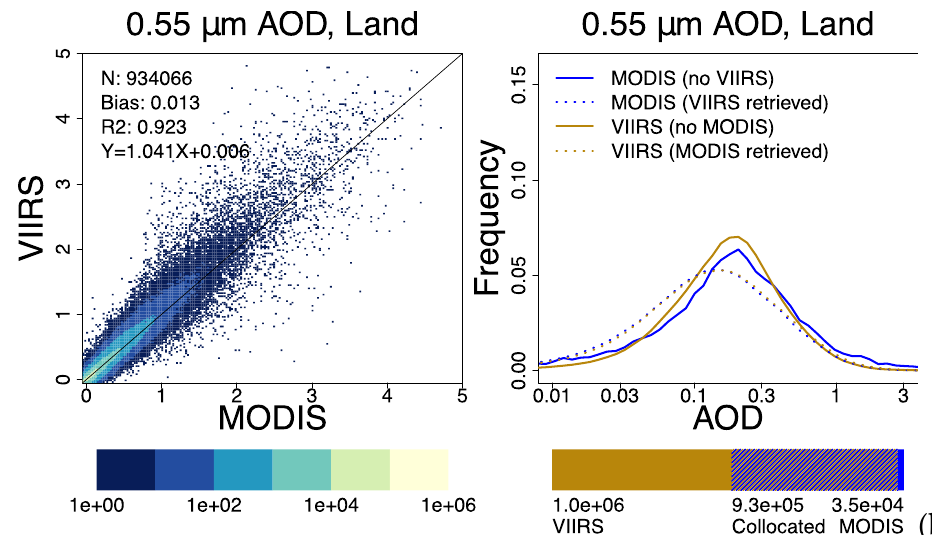
Figure 5. Comparison of all 0.55 µ m AOD daily average one-degree grid cells throughout 2015. Left, scatterplots of collocated MODIS Aqua and VIIRS SNPP cells; right, histogram frequencies where MODIS and VIIRS were collocated (dotted lines) and where only one sensor retrieved AOD (solid lines). The horizontal bar on the right indicates the number of collocated and non-collocated grid cells for each sensor. AOD values are ( a ) over ocean and ( b ) over land.